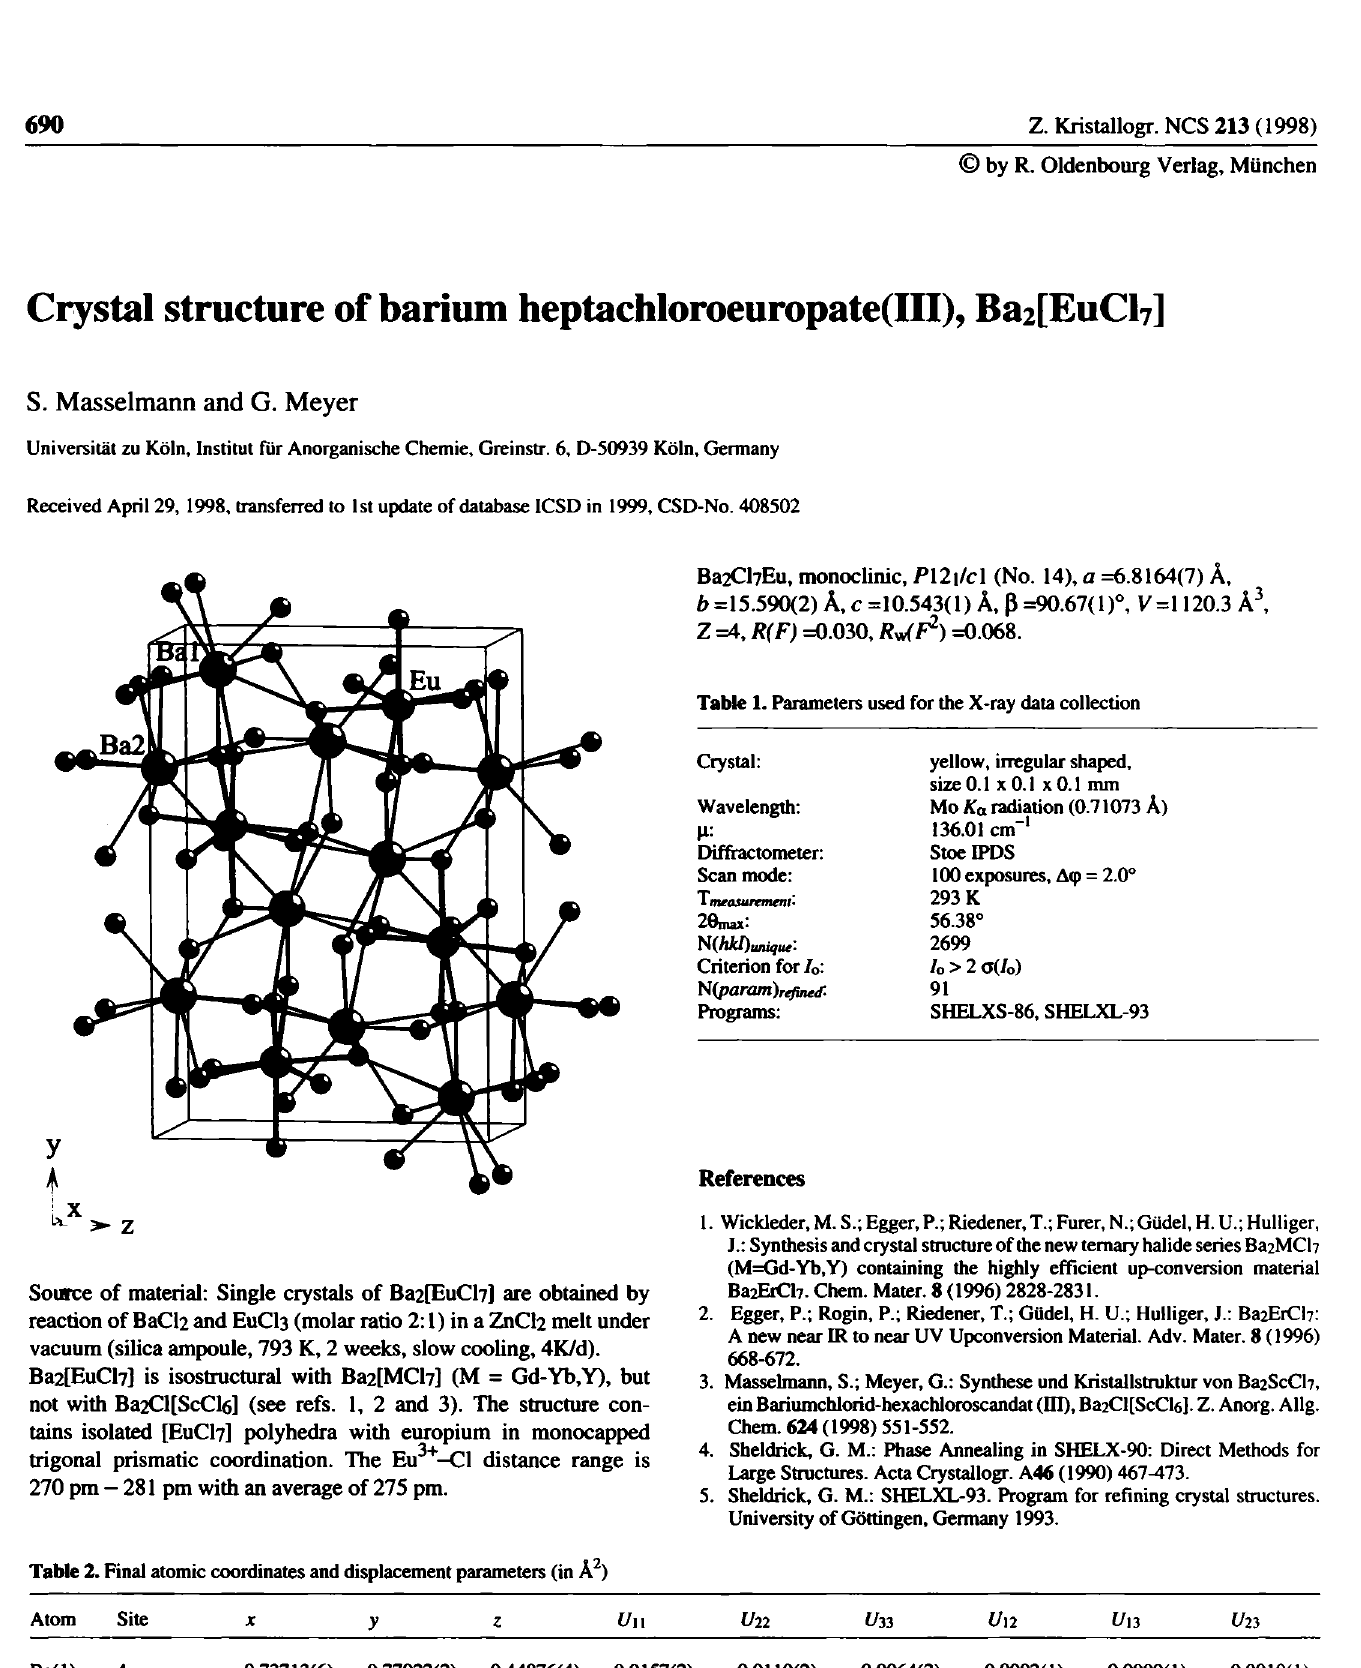
Table 2. Final atomic coordinates and displacement parameters (in Â^)